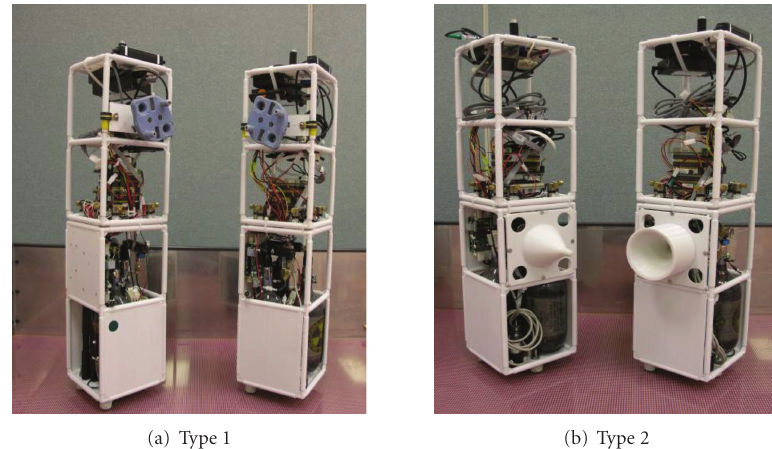
Figure 2: (a) Patent pending docking interface design (electromagnet and fluid transfer capability). (b) Concept (male/female) docking interface used for the experiments in this paper.